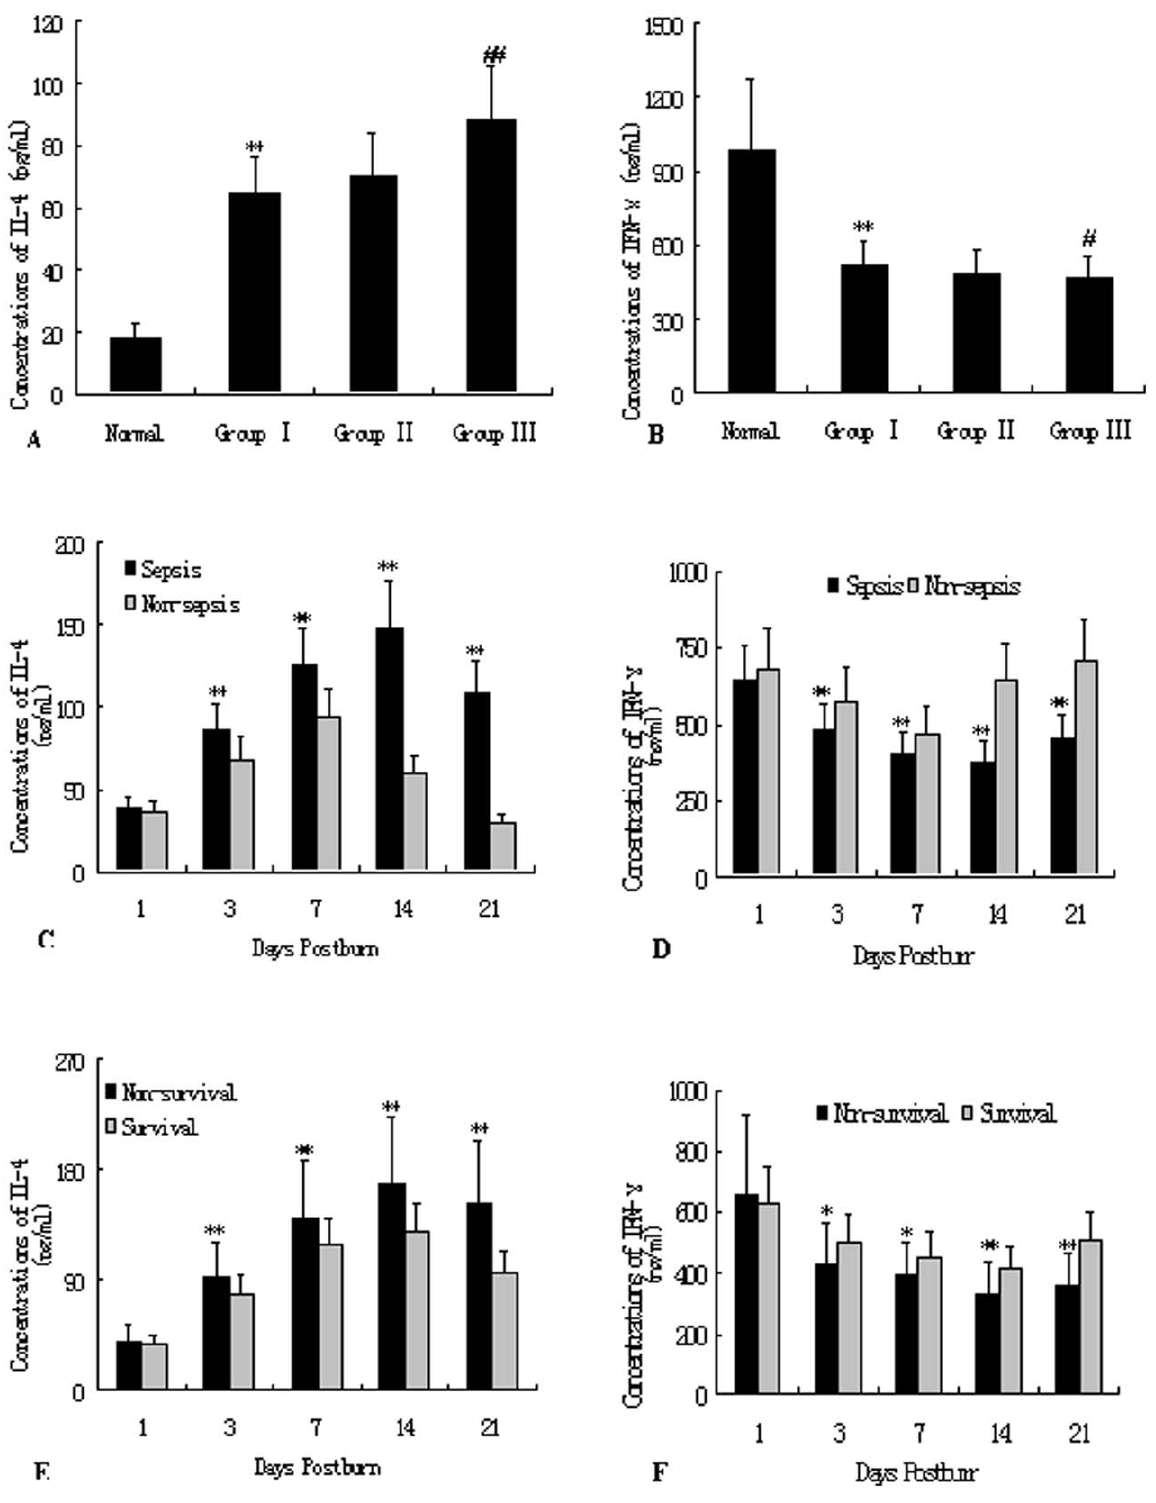
Figure 5. ELISA analysis of of IL-4 and IFN- c released by T cells. Levels of IL-4 produced by T cells response to PHA increased markedly after burn injury, whereas levels of IFN- c decreased markedly as compared with normal control group, and there were obvious differences between group I and group III, indicating that Th cells might have shifted to Th2 cells (as shown in Fig. 4A and 4B). The similar results were obtained in non-MODS patients and the survival group as compared with those with MODS and the non-survival group on PBD 3–21 (as shown in Fig. 4C , 4F). *P , 0.01, **P , 0.01, Group I vs. normal group, or MODS group vs. non-MODS group, or non-survivors group vs. survivors group; # P , 0.01, ## P , 0.01, Group III vs. Group I.